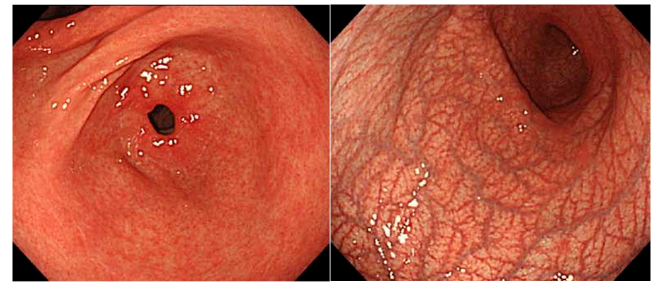
Figure 2. Image of endoscopic reversed atrophic type gastritis.